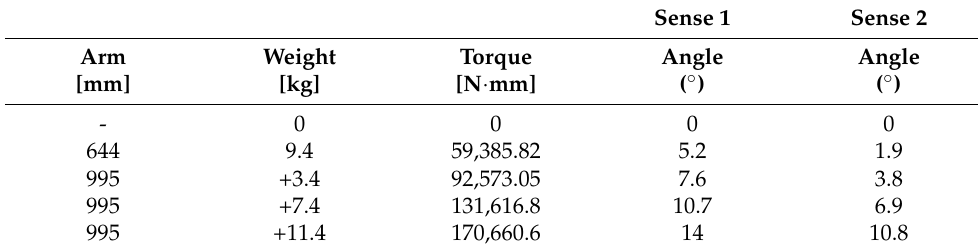
Table 1. Load data and measured effect (bending angle of the